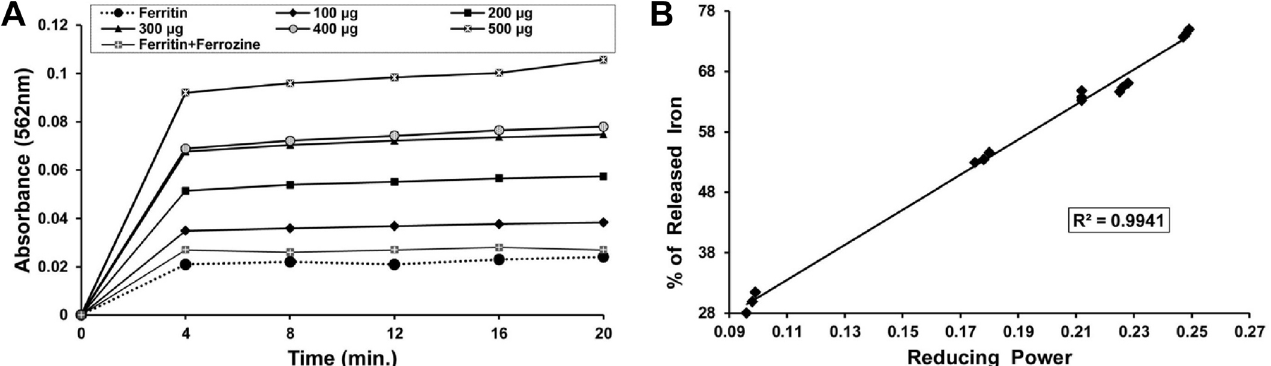
Fig 10. Effect of DBME on reductive release of ferritin iron and its correlation with Fe 2+ reducing power. (A) Reductive release of ferritin iron (B) correlation between released ferritin iron with reducing power. The iron released in response to the increasing amounts (100 – 500 μ g) of DBME was plotted against reducing power displayed by the same doses.Dose dependent formation of the [Fe(ferrozine) 3 ] 2+ complex following release of Fe 2+ from ferritin by different doses of DBME and single dose of desirox. The reductive release of ferritin iron was quantified by measuring the formation of the ferrous complex of ferrozine, [Fe(ferrozine) 3 ] 2+ at 562 nm using a Shimadzu UV-VIS spectrophotometer.